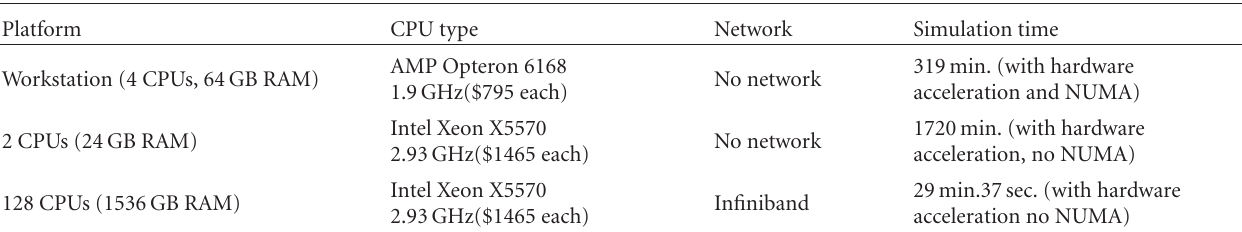
Table 2: Performance comparison of parallel FDTD method on 4-CPU workstation and high-performance cluster.